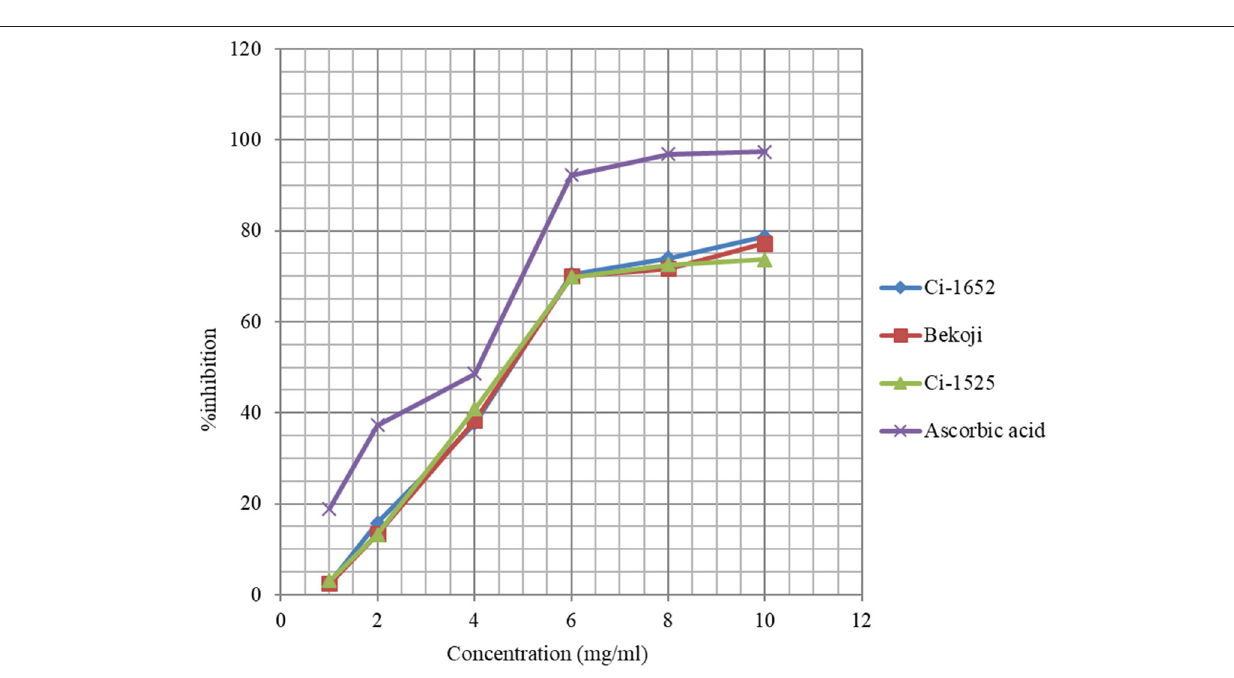
solvent on oil and bioactive composition of commercial Indian niger seed. The RSA of niger seed extracted with acetone, methanol, and ethanol could be attributed to the presence of high amounts of bioactive molecules such as tocopherols,